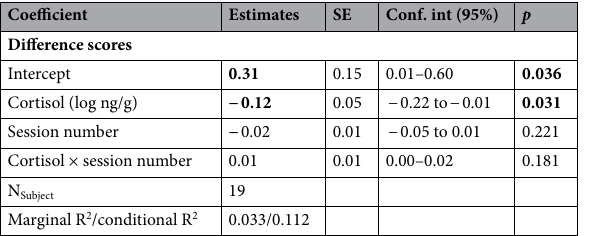
Table 2. Linear mixed-model of difference score predicted by average cortisol and session number, with subject included as a random effect. Significant estimates and their p values are